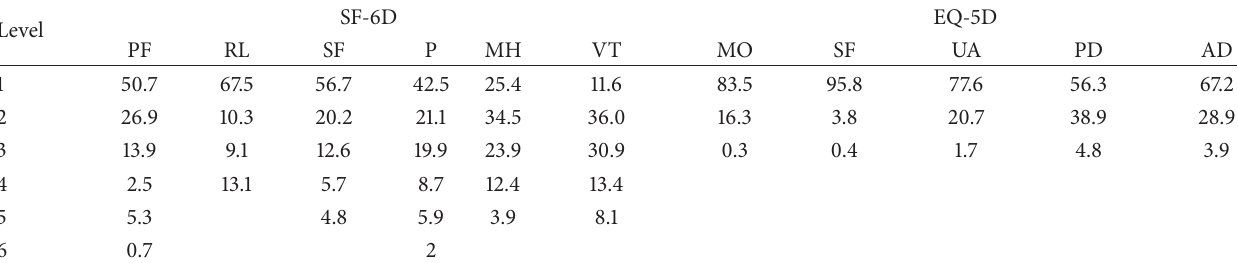
Table 2: Distribution of health state levels in SF6D and EQ5D (in percentages).